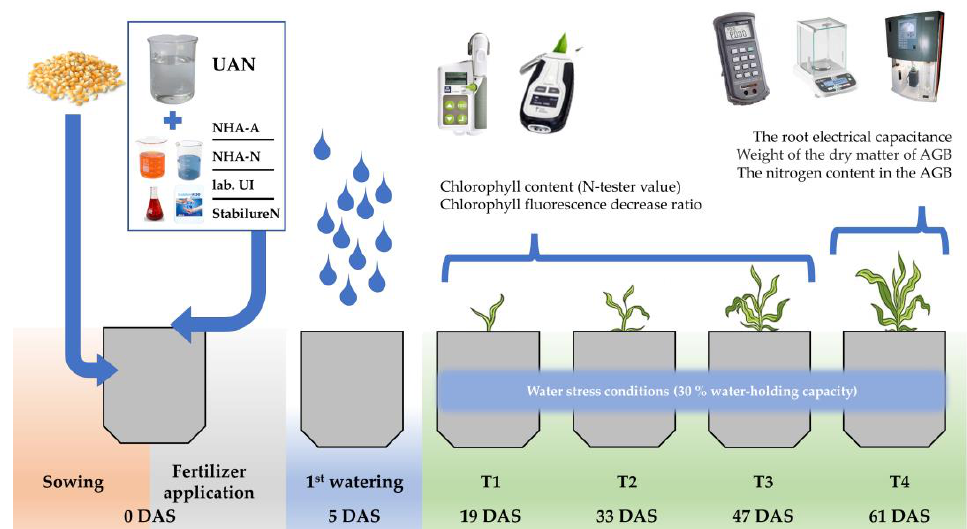
Figure 6. Timetable of the greenhouse pot experiment. DAS — day after sowing.